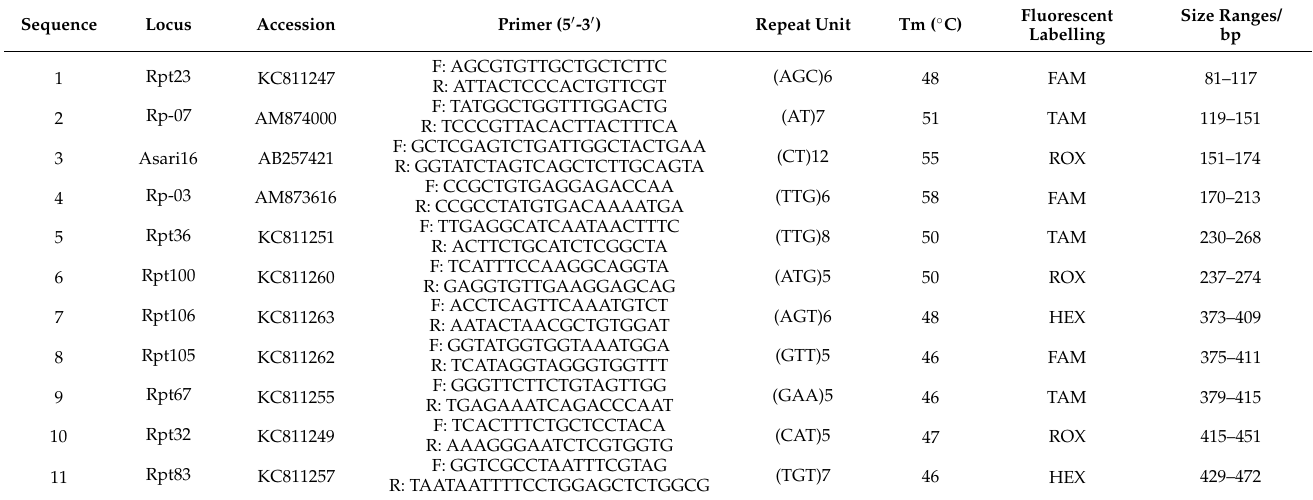
Table 2. Primer sequences and information about microsatellite loci from Ruditapes philippinarum